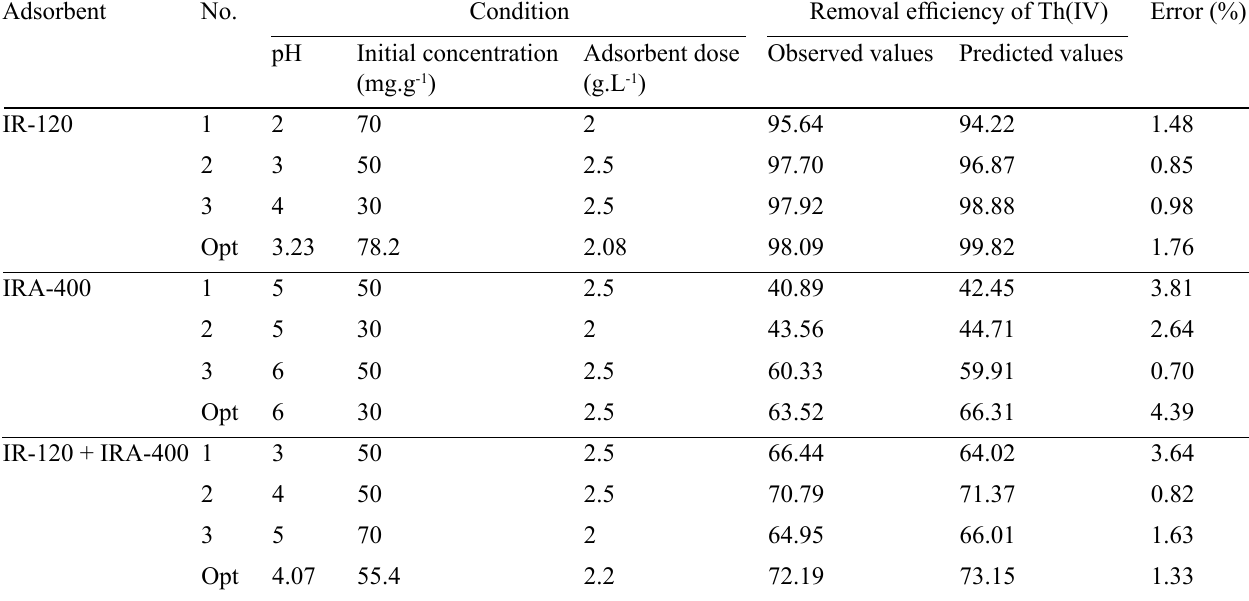
Table 5. Verification experiments for adsorption of Th(IV) ions onto resin of IR-120, IRA-400 and the mix of them.